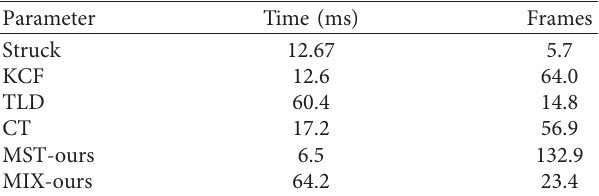
Table 1: Classification of people flow density levels.